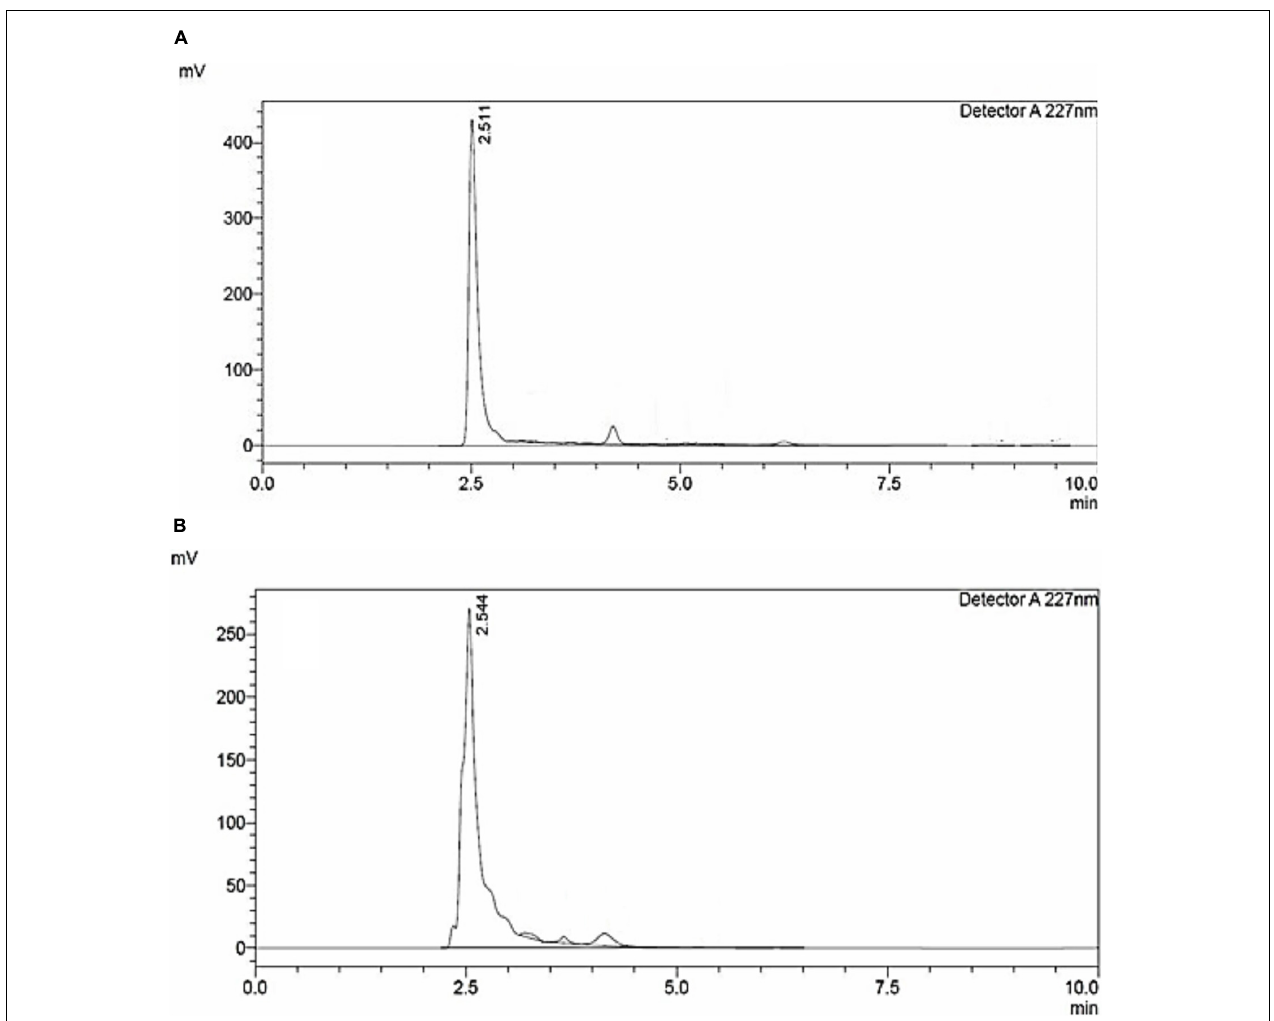
FIGURE 1 | HPLC chromatogram of (A) 2,3-Dihydroxybenzoic acid; standard. (B) Catecholate siderophore purified from E. coli culture.